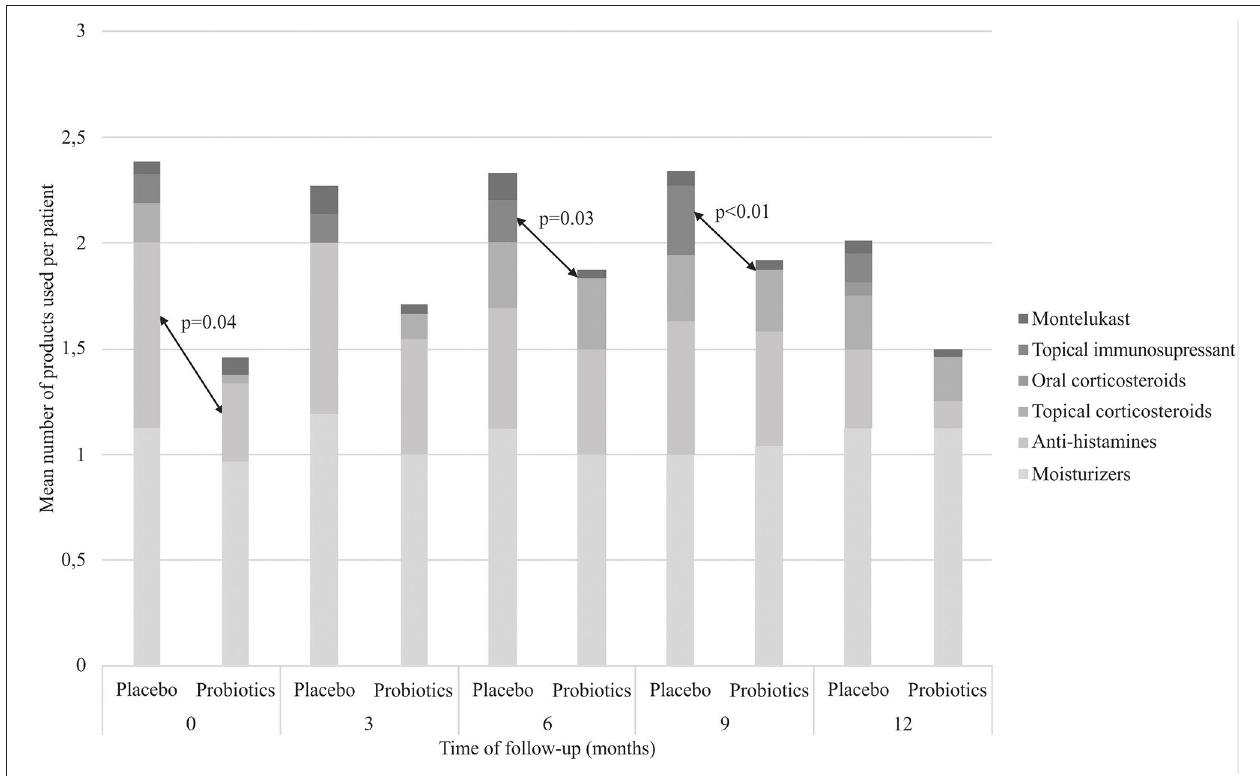
FIGURE 3 | Mean number of medicines used by patients at each time point of follow-up.